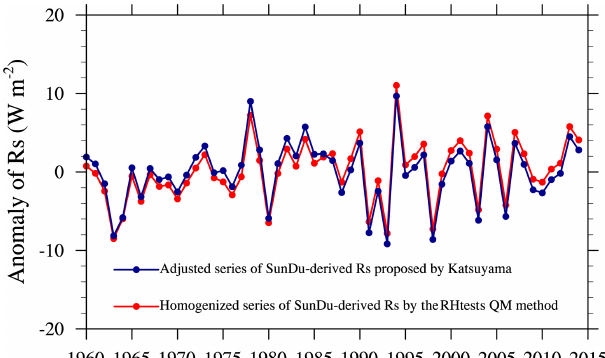
Figure 2. The fraction of stations that suffer from data inhomo- geneity due to site relocation, the change of instruments, and the measurement method for sunshine duration (SunDu) records, cloud amount (CA) records, and surface incident solar radiation ( R s ) records. In total, there were 156 stations with SunDu records, 105 of which had R s records and 155 of which had CA records. The inhomogeneity information shown here was derived from meta- data from https://www.data.jma.go.jp/obd/stats/data/en/smp/index. html (last access: 21 January 2022) and was used as primary in- formation to perform the inhomogeneity adjustment in the RHtests method detailed in Sect. 2.2.